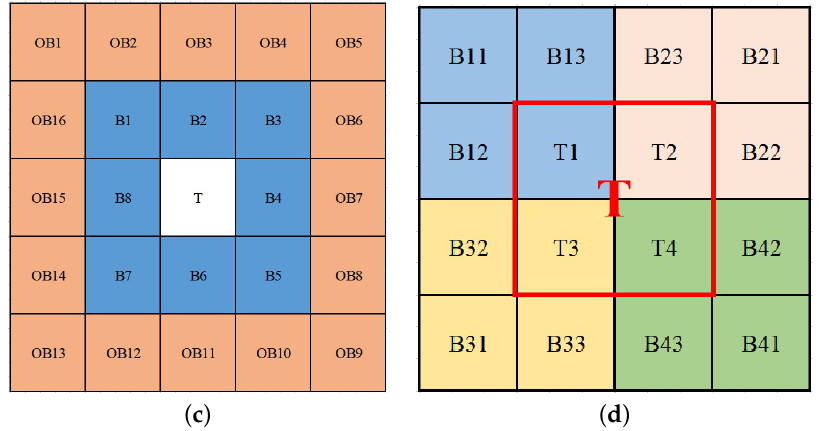
Figure 1. Window detection framework: ( a ) traditional window detection framework; ( b ) triple-layer window detection framework; ( c ) double neighbor window detection framework; ( d ) double-layer nested